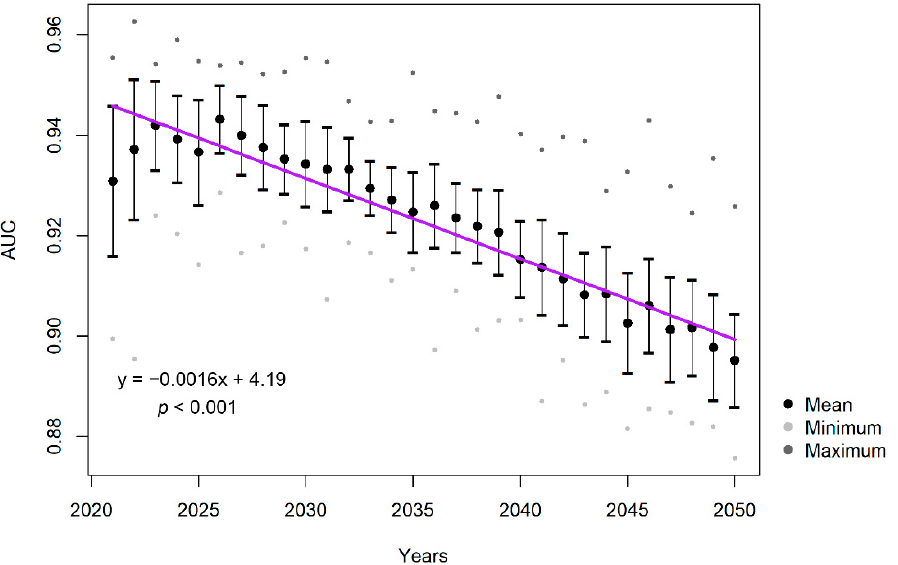
Figure 7. The area under the curve (AUC) values of MaxEnt models over the simulation period 2021–2050.